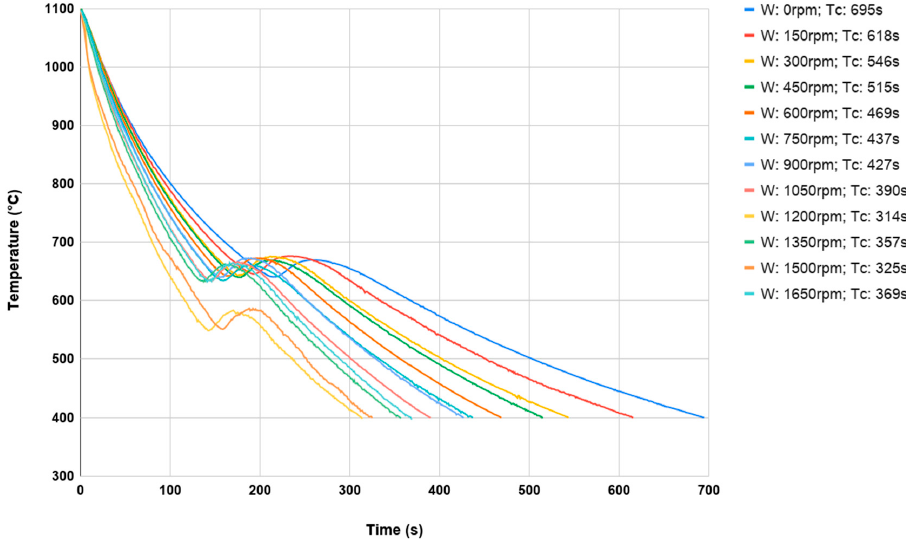
Figure 10. The cooling curves of a samples made of C45 35 × 40 mm from forging temperature 1100 °C to 400 °C.